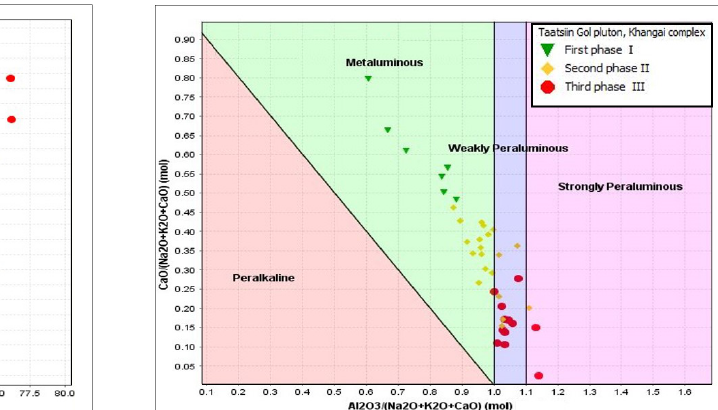
Fig 12. SiO2-K2O diagram (Rickwood, 1989) Fig 13. ASI diagram (Barton and Young, 2002)